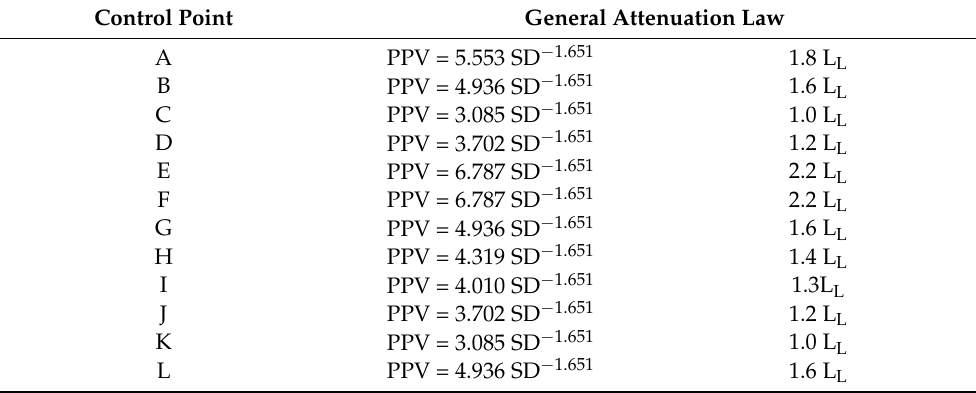
Table 3. Local attenuation laws with a 95% confidence interval and comparison with L L